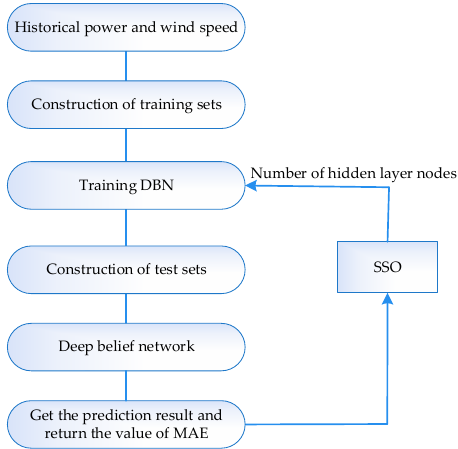
Figure 5. Flow chart of the SSO ‐ DBN forecasting model.